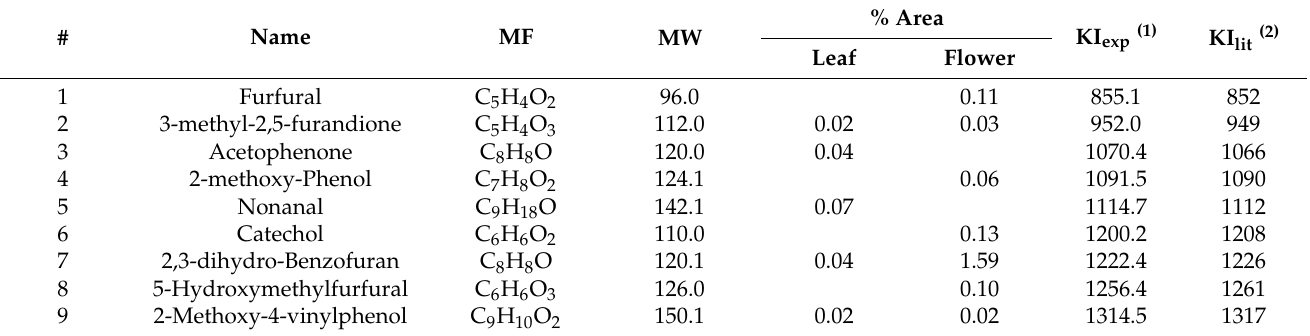
Table 6. Volatile and semi-volatile compounds identified in leaf and flower ethyl acetate fractions of Pelargonium peltatum by